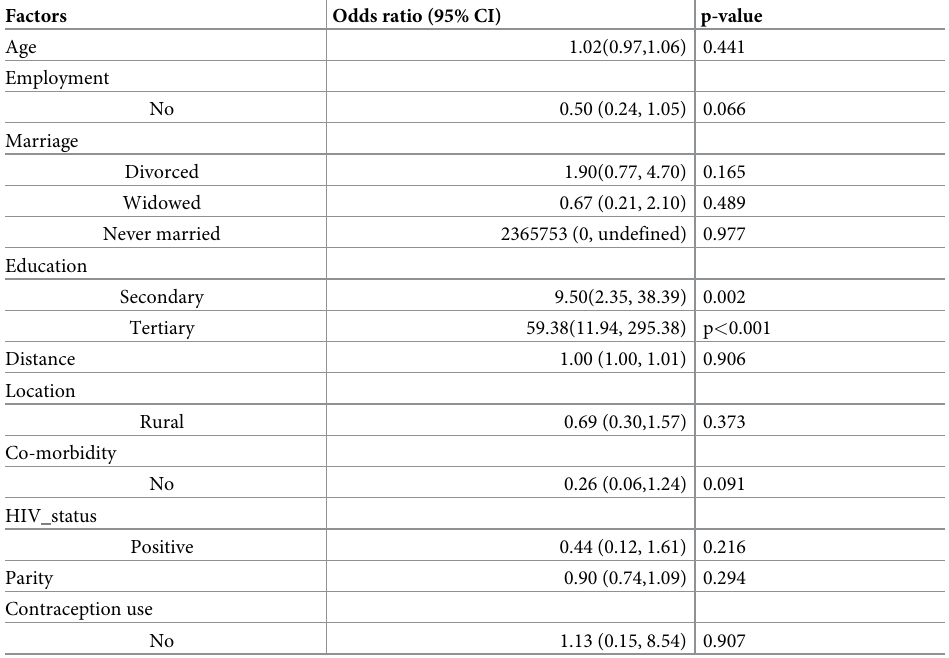
Table 3. Ordered logistic regression analysis for factors explaining prevention (screening uptake) (n =